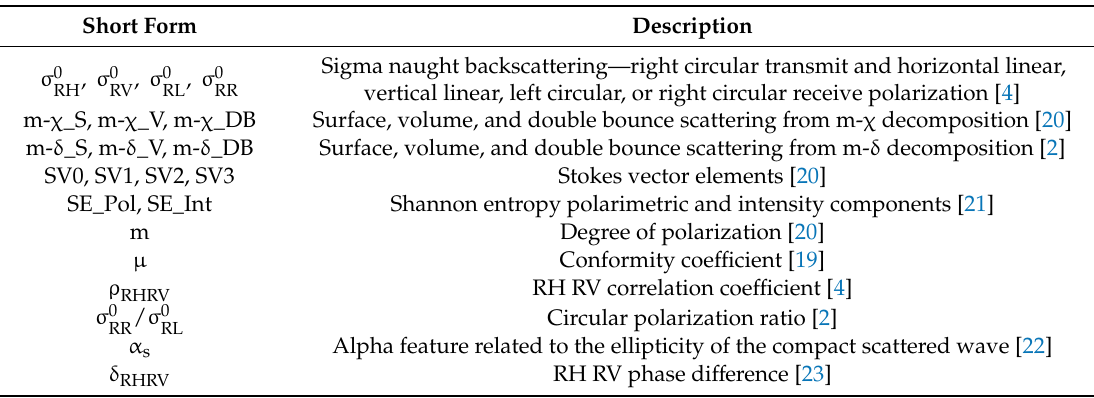
Table 2. Assessed Compact Polarimetric (CP)